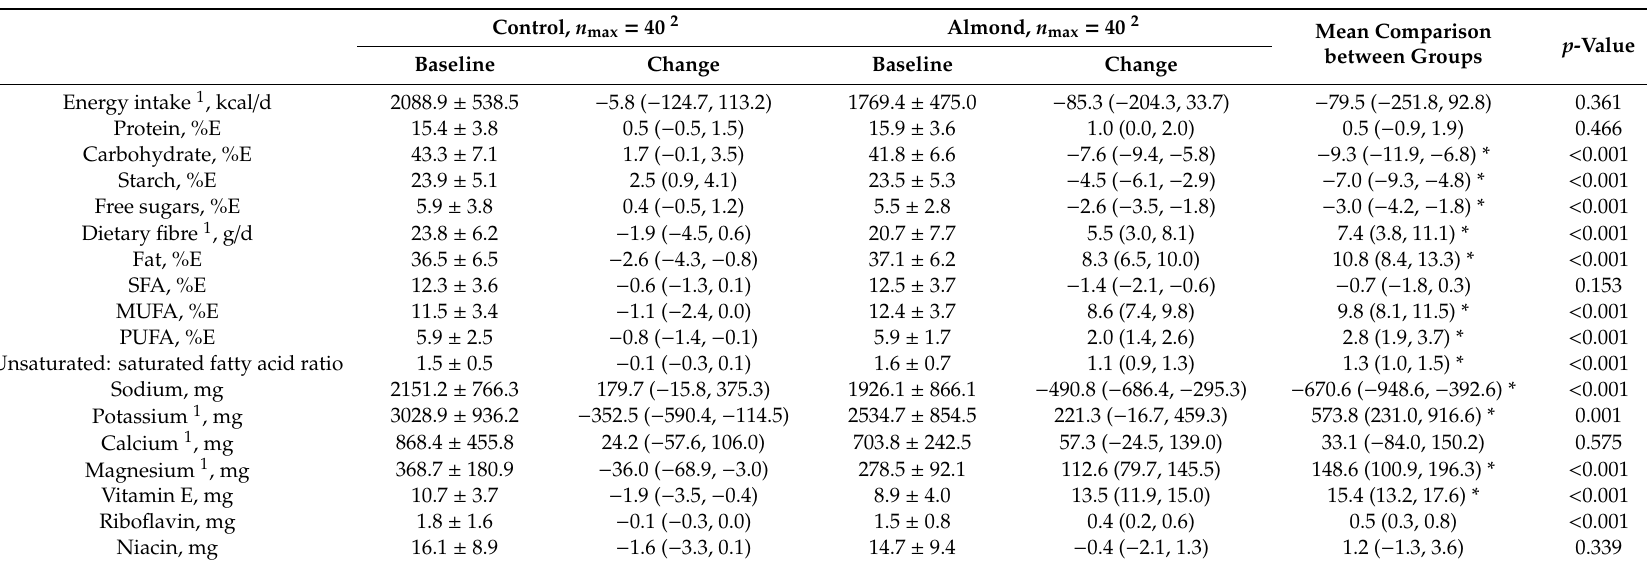
Table 2. Nutrient intakes estimated from 4-d food diaries at baseline (prior to run-in) and the final week of the dietary